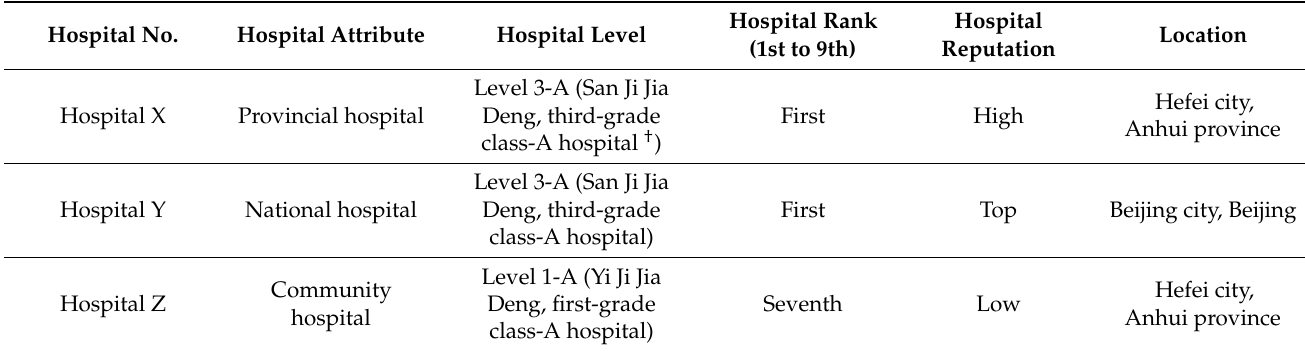
Table 2. Description of targeting hospitals using AI systems provided by iFlytek. Hospital No.